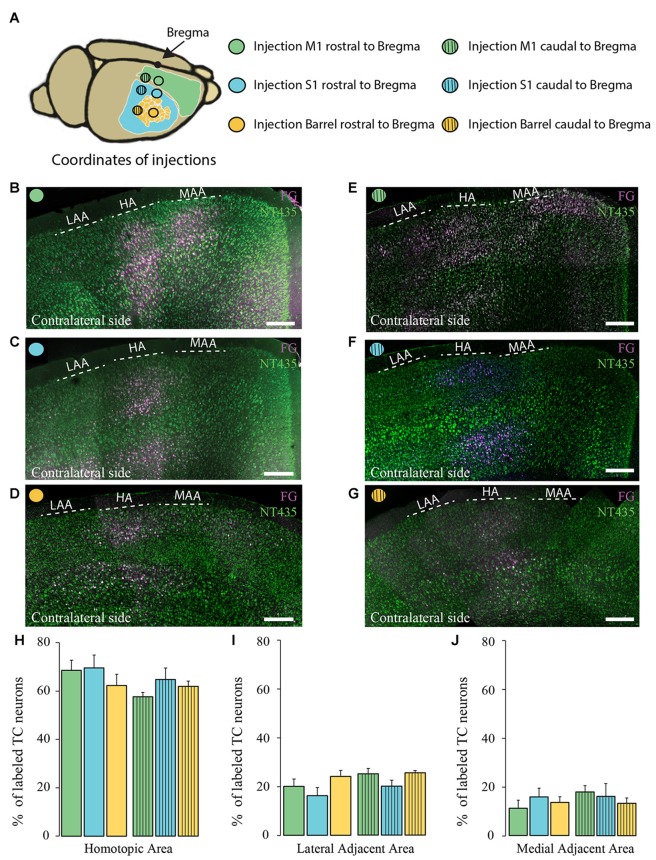
Comparison of the homotopic organization of transcallosal projection neurons across different brain regions. (A) Scheme of the stereotactic coordinates used for retrograde tracing in the study. (B–G) Confocal images of the contralateral cortex following injection of a retrograde tracer in motor cortex (rostral to Bregma; B), somatosensory cortex (rostral to Bregma; C), barrel cortex (rostral to Bregma; D), motor cortex (caudal to Bregma; E), somatosensory (caudal to Bregma; F), barrel cortex (caudal to Bregma; G) showing the homotopic organization of transcallosal projection neurons. (H–J) Quantification of the repartition of the transcallosal projection neurons in the contralateral cortex in the HA (H), the LAA (I) and the MAA (J). Full bars, injections in the cortex rostral to Bregma; dashed bars, injections in the cortex caudal to Bregma; green: injection in the motor cortex, blue: injection in the somatosensory cortex and yellow: injection in the barrel cortex. Scale bars equal 250 μm in (B–G). One-way Anova followed by Tukey test were used for each area.